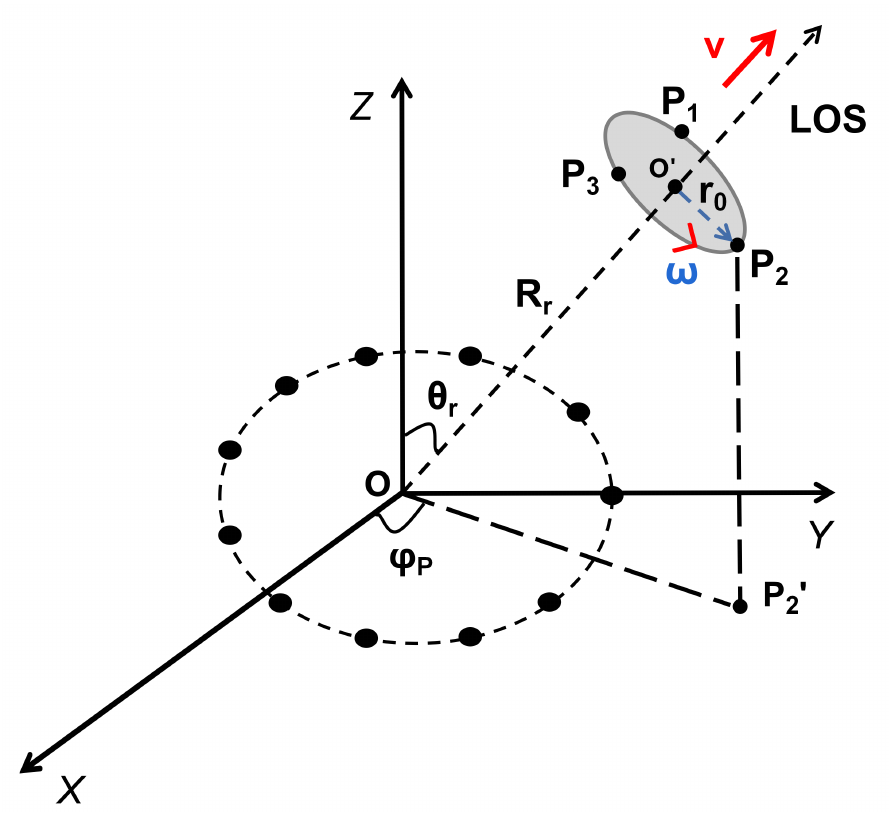
Figure 1. The detection model of a rotational object in VEMW-based radar